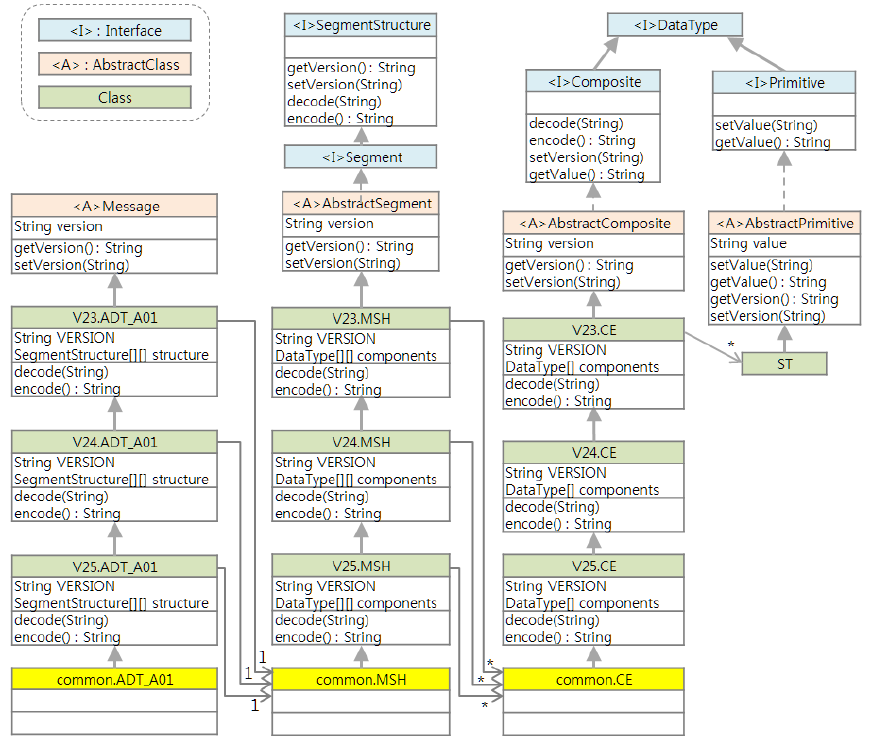
Fig. 2. Enhanced OOD-based conceptual structure of HL7 V2